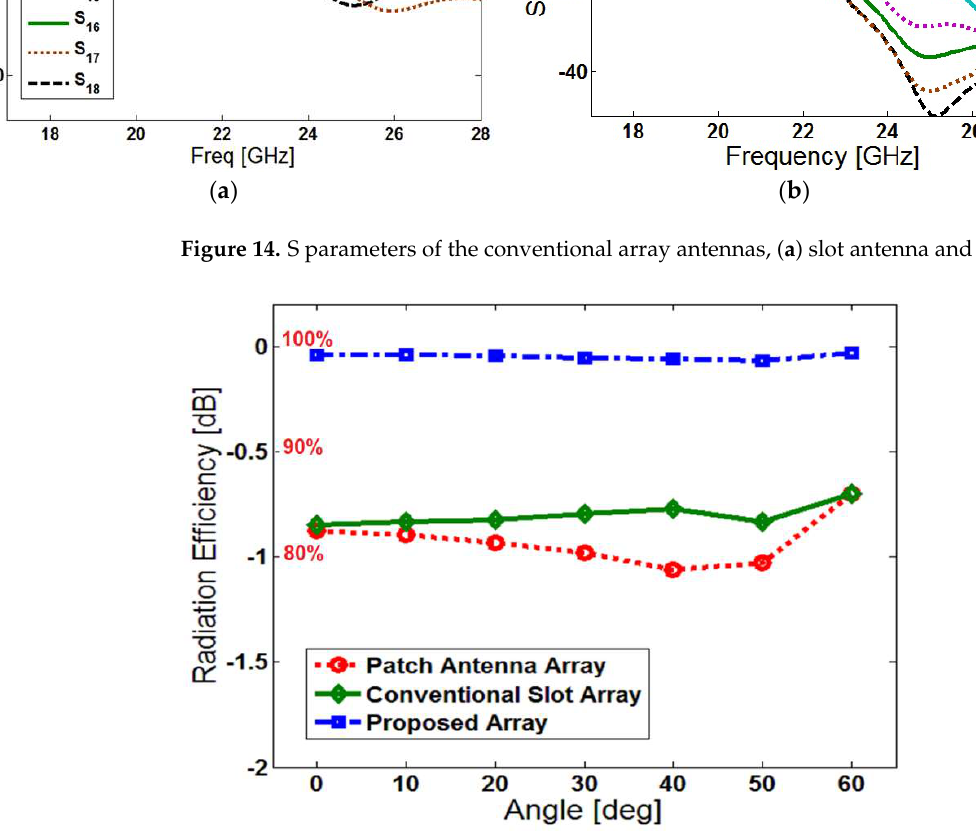
Figure 15. Comparison between the radiation efficiencies of the arrays illustrated in Figure 12 and the proposed design.